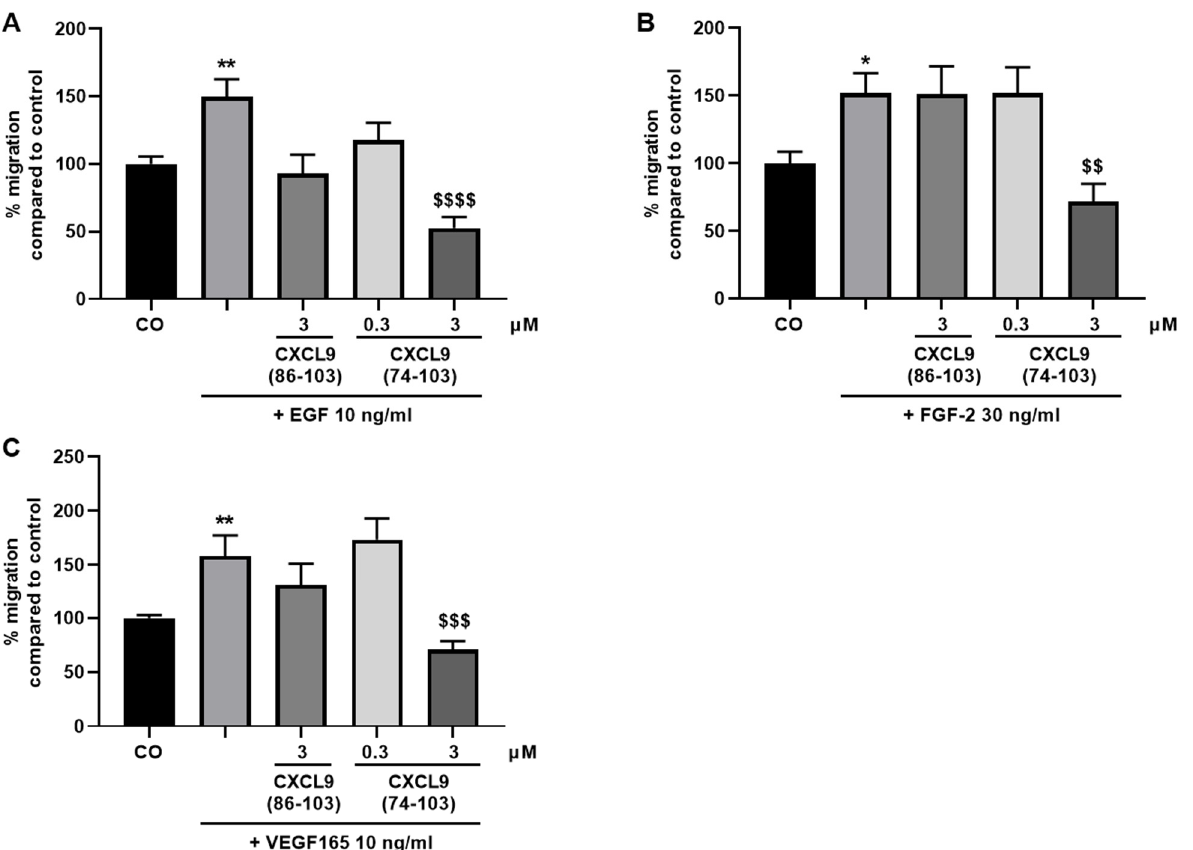
Figure 2. CXCL9(74-103) reduces growth factor-induced endothelial cell migration. HMVEC chemotaxis in a CIM plate towards ( A ) EGF, ( B ) FGF-2, or ( C ) VEGF165 in the presence or absence of CXCL9-derived peptides was measured using the xCELLigence RTCA DP System. Changes in electrical impedance were converted into cell indices as a measure of migration. The data are represented as a mean ( ± SEM) percentage of migration compared to the control (100%). [n ≥ 3; Mann–Whitney U test; * p < 0.05, ** p < 0.01 (compared to control); $$ p < 0.01, $$$ p < 0.001, $$$$ p > 0.0001 (compared to growth factor)].